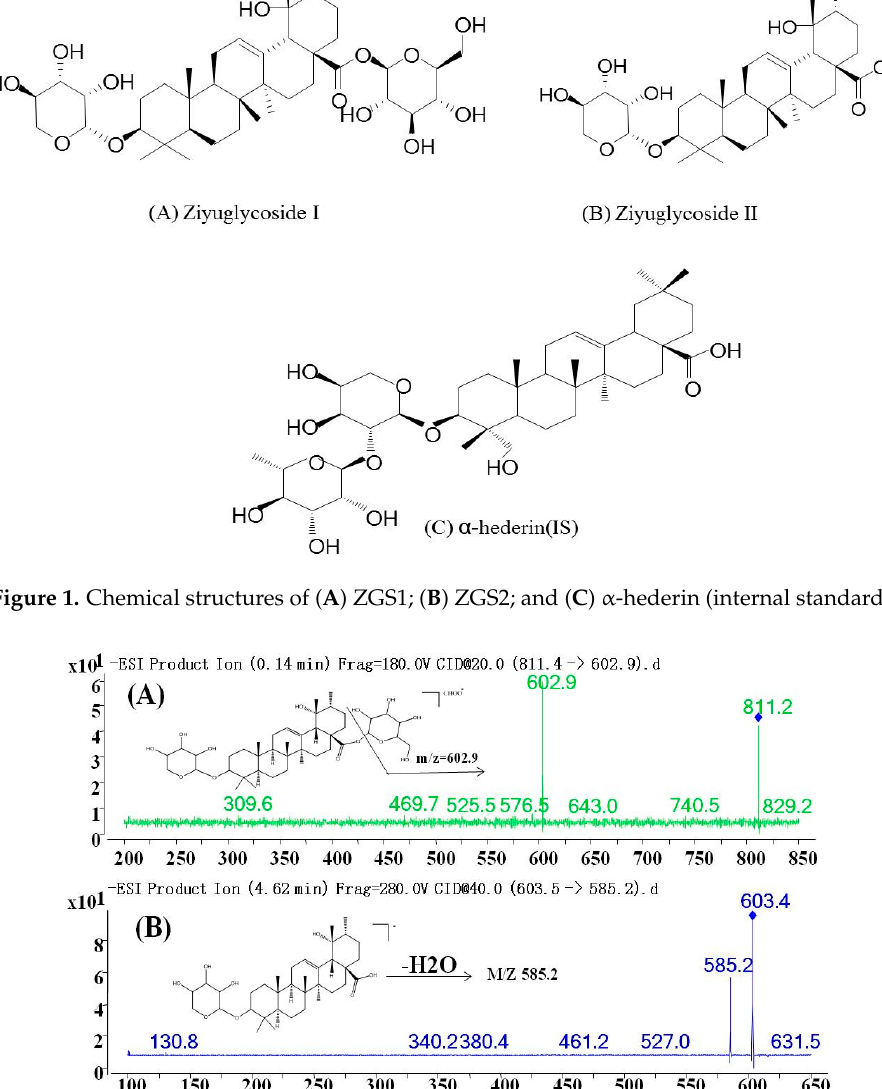
Molecules 2018 , 23 , x 3 of 14 Table 1. Retention time (t R ), optimized MS/MS transitions, fragmentor voltage (FV) and collision